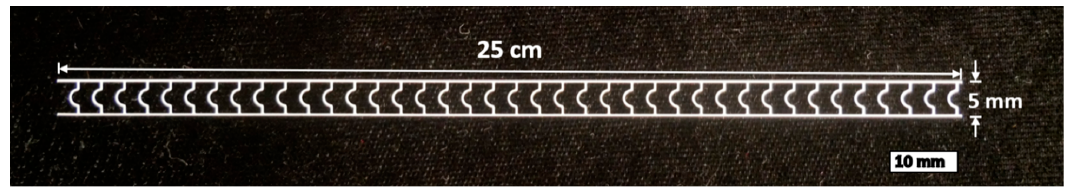
Figure 3. Picture of photochemically-etched Zn ribbon.